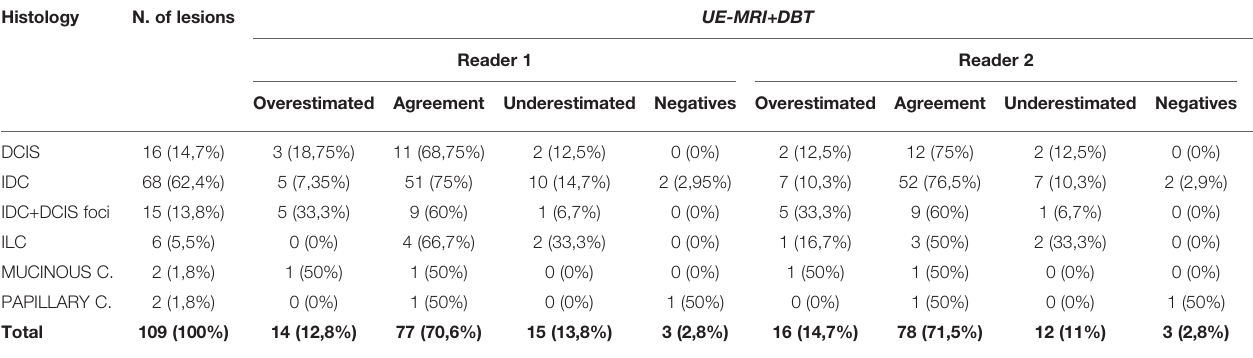
TABLE 1 | Concordance in terms of lesion size assessment of the malignant lesions detected with UE-MRI+DBT and histology. Histology N. of lesions UE-MRI+DBT Reader 1 Reader 2 Overestimated Agreement Underestimated Negatives Overestimated Agreement Underestimated